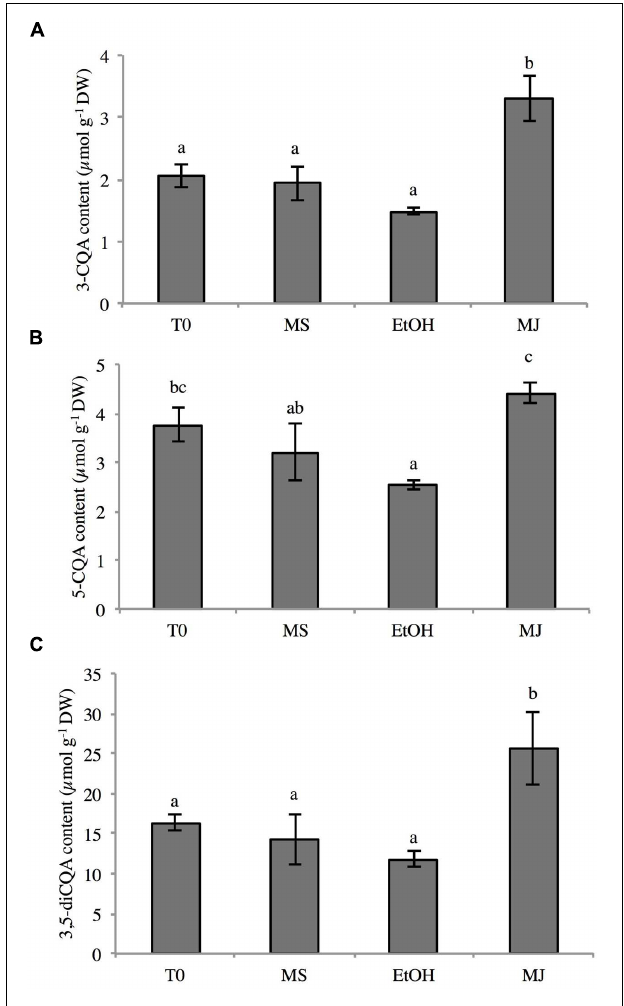
FIGURE 4 | Contents of 3-CQA (A), 5-CQA (B), and 3,5-diCQA (C) in chicory cell cultures under different conditions. Methanolic extracts were analyzed by HPLC. T0: cell culture sampled before elicitation, MS: cultures kept on MS medium for 24 h, EtOH: cell cultures treated with ethanol for 24 h, MJ: cell cultures treated with 50 µ M MeJA for 24 h. Values are means of three replicates ± SD. Different letters in the same histogram indicate significant differences detected using ANOVA ( P <